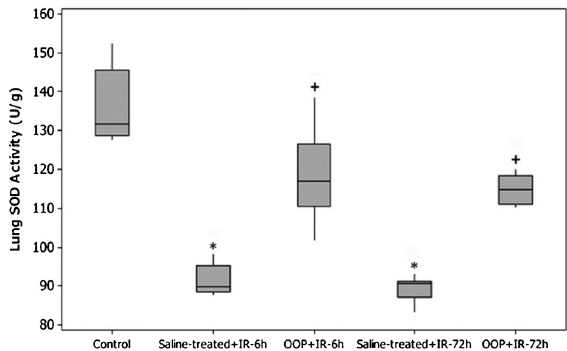
Figure 4. Superoxide dismutase (SOD) activity in the lung tissues of control, saline-treated++ionizing radiation (IR), or ozone oxidative preconditioning (OOP)++IR groups decapitated at 6 or 72 h after irradiation. Each group consisted of 8 rats. *P=0.001 compared to control group; + P=0.001 compared to saline-treated group (Mann-Whitney U-test).